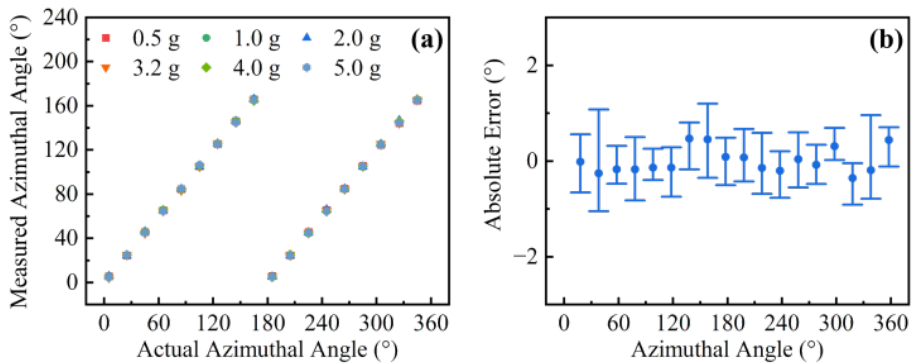
Figure 6. ( a ) Actual and measured orientation angle at various accelerations ranging from 0.5 to 5.0 g and ( b ) corresponding accuracy ranges.